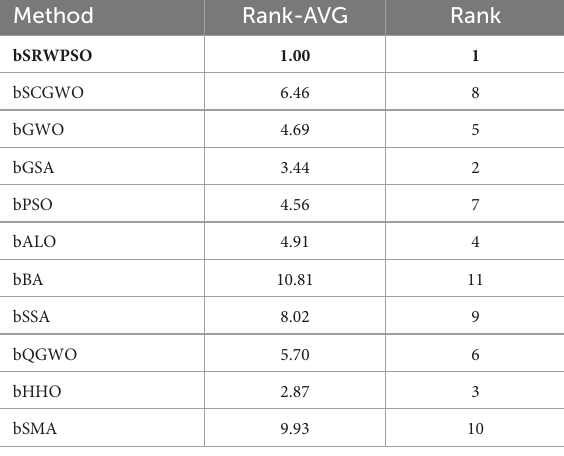
TABLE 16 The results of Friedman ranking for